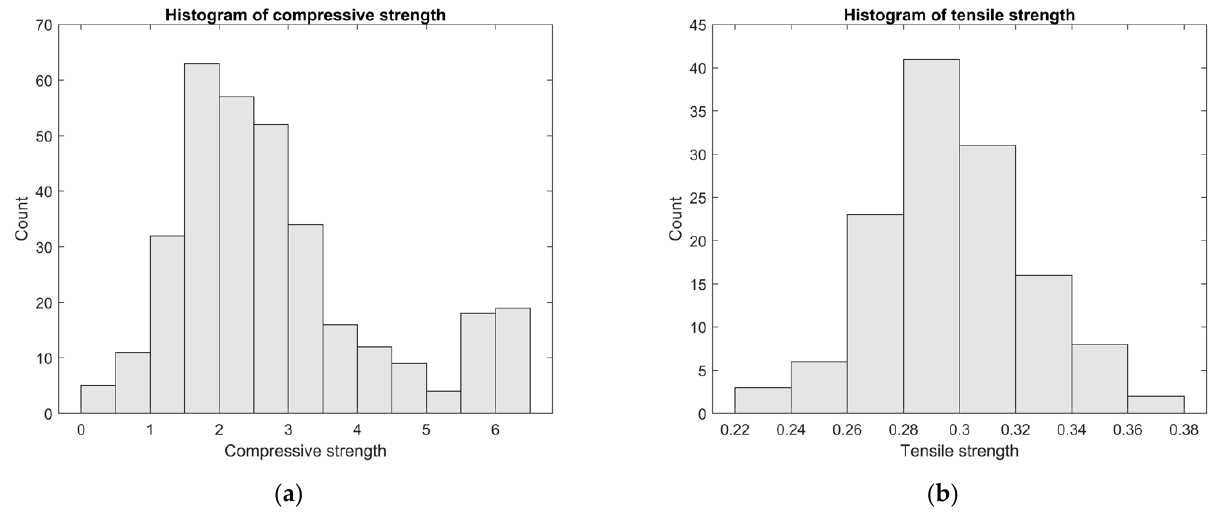
Figure 6. Histograms of the target values: ( a ) uniaxial compressive strength; ( b ) tensile splitting strength.